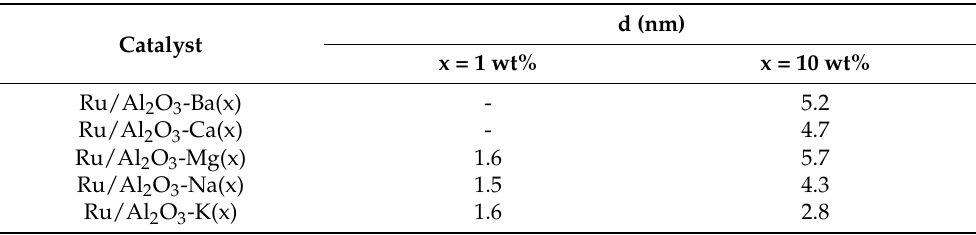
Table 1. Average metallic particle size (d) of Ru catalysts deposited on alumina doped with 1 and 10 wt% A/AE metals. d (nm) Catalyst x = 1 wt% x = 10 wt% Ru/Al 2 O 3 -Ba(x) - 5.2 Ru/Al 2 O 3 -Ca(x) - Ru/Al 2 O 3 -Mg(x) Ru/Al 2 O 3 -Na(x) Ru/Al 2 O 3 -K(x) Ru/Al 2 O 3 : d = 1.7